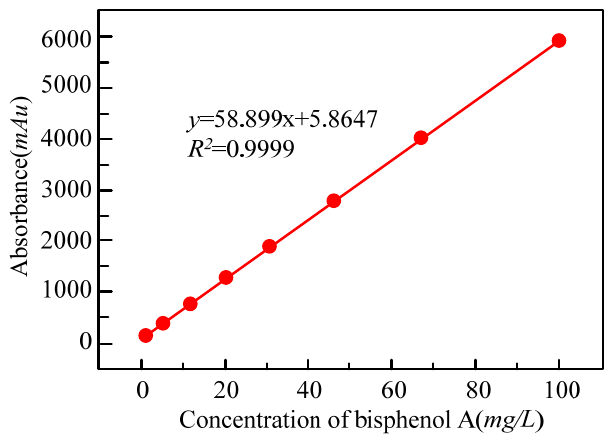
Figure 2. The standard curve of bisphenol A concentration.